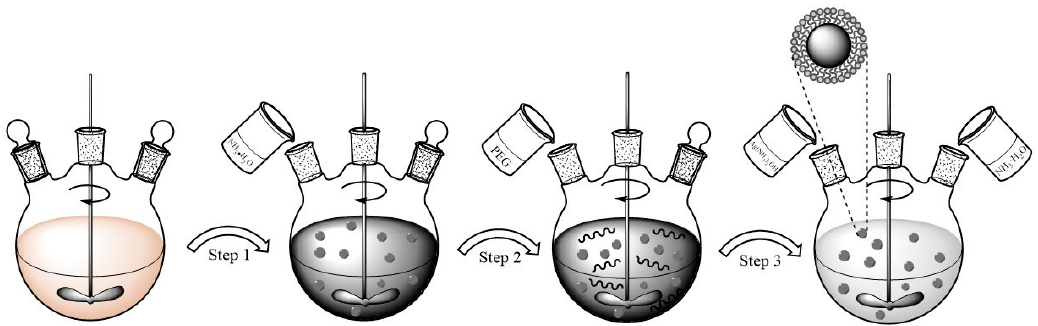
Figure 1. Schematic synthesis of Fe 3 O 4 @Ag nanoparticles.